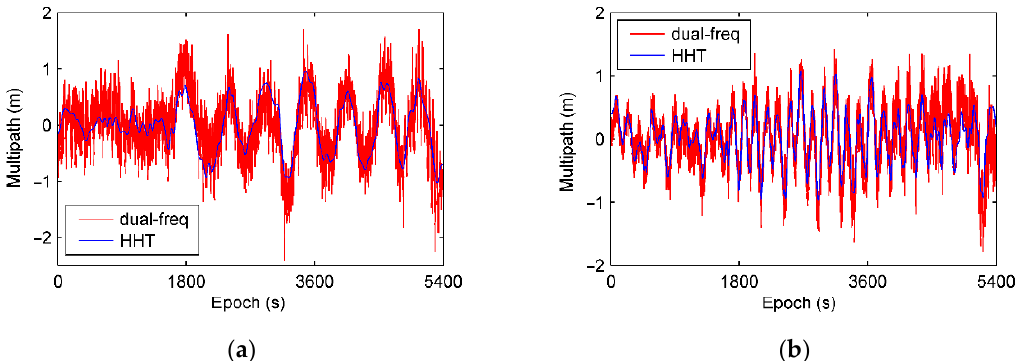
Figure 13. Comparisons of multipath extracted by HHT and computed from dual-frequency combination. ( a ) C09 and ( b ) G19.